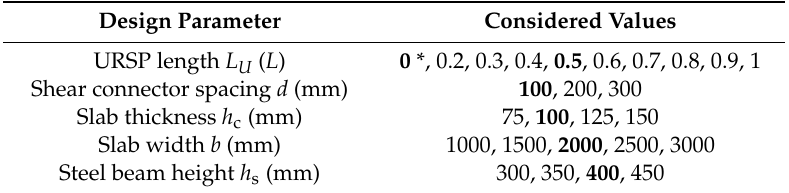
Table 1. Design parameters for load case